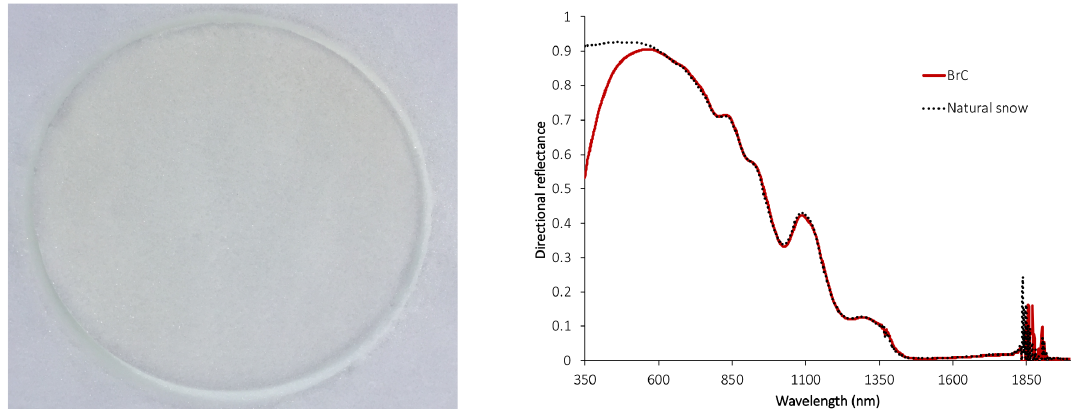
Figure 6. Image and HCRF spectra for a BrC deposition and adjacent natural snow in May 2017 at the Tamarack Lake site. This BrC deposition drastically reduced the high natural snow reflectivity in the ultraviolet and short-wavelength visible (<500nm) spectral regions. Solar zenith: 34.6 ◦ ; solar azimuth: 235.0 ◦ .